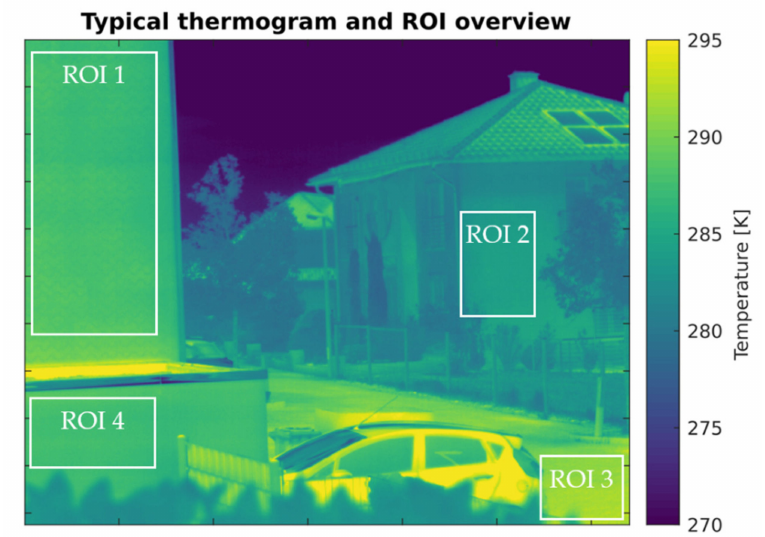
Figure 4. Typical thermogram of the scene with the selected ROIs of the experiment. ROI 1 is the left building wall, ROI 2 the right building wall, ROI 3 is the paved road, and ROI 4 the garage sidewall.